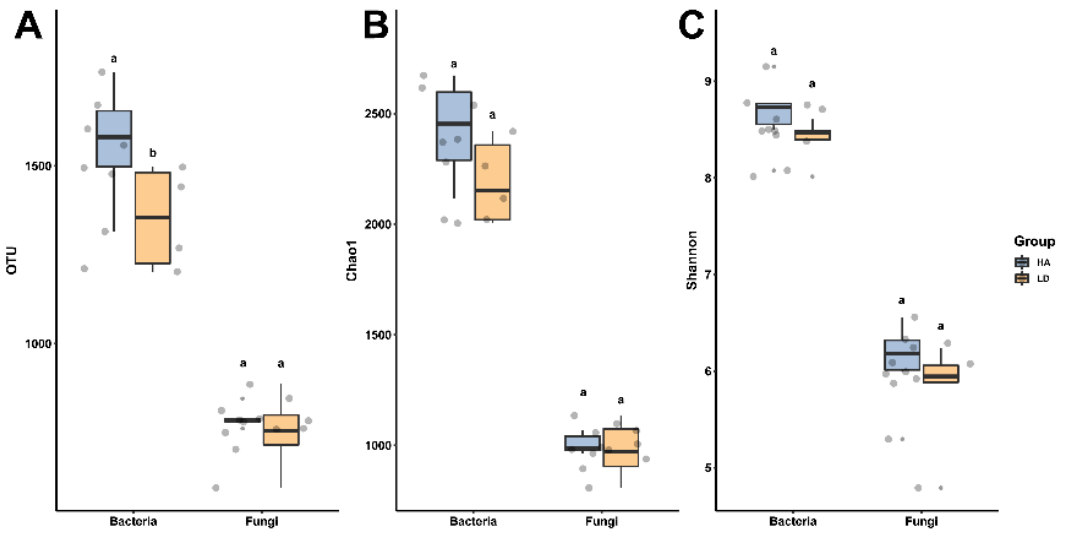
Figure 1. The influence of humic acid on the OTU ( A ), Chao1 ( B ) and Shannon ( C ). LD and HA represent decline diseased bayberry in the absence and presence of humic acid, respectively. Significant changes ( p < 0.05) are indicated by values with distinct lowercase letters between the absence and presence of humic acid.